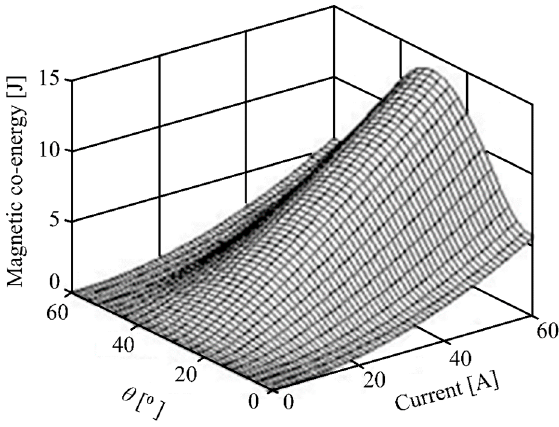
Figure 12. Magnetic co-energy surfaces.